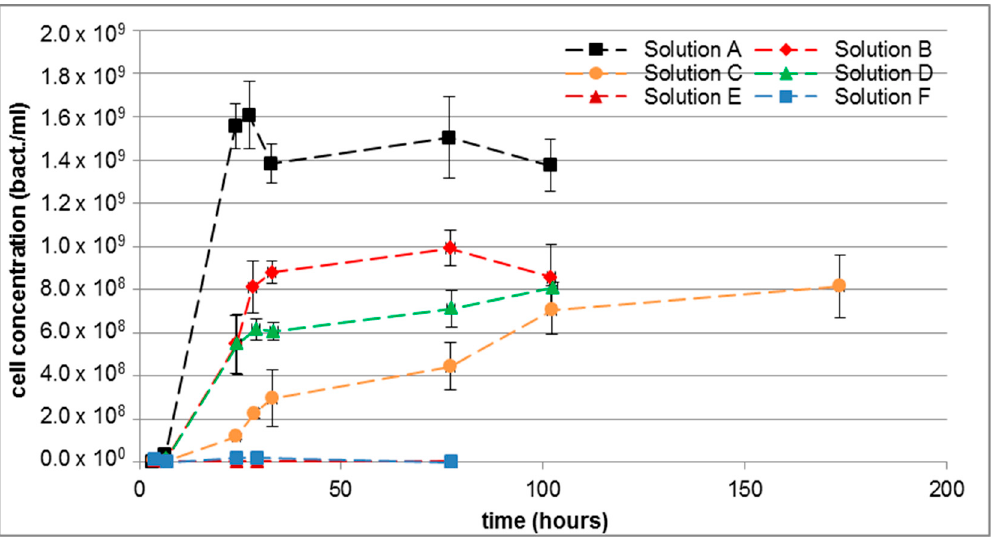
Figure 2. Bacterial growth curves in different culture